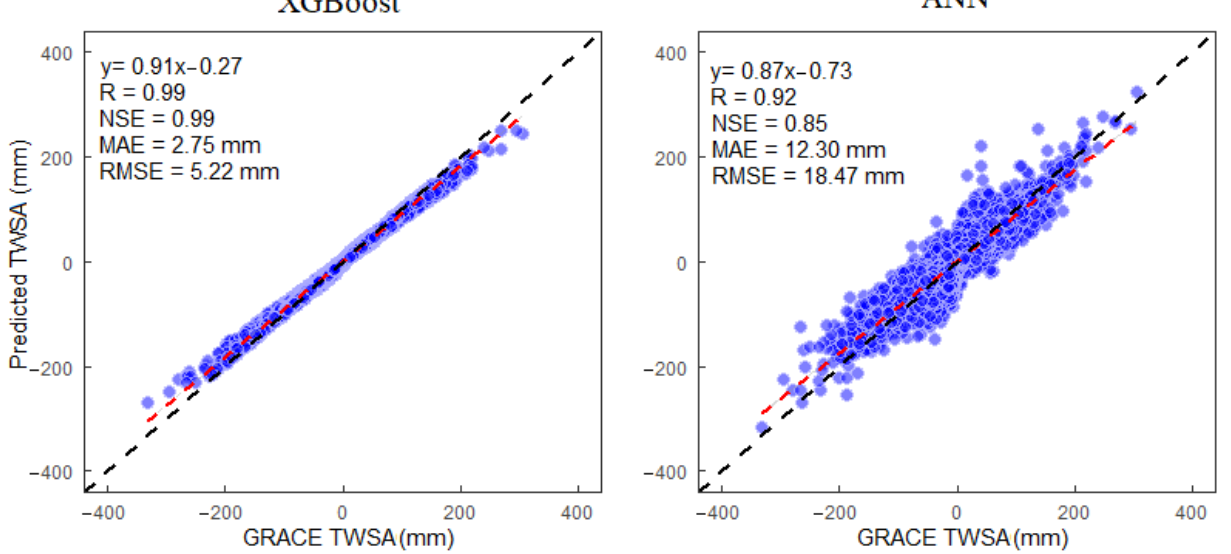
Figure 3. Illustration of machine learning models accuracy in one-one graphs. The dashed black line shows the one-one line and the dashed red line shows the linear trend line.